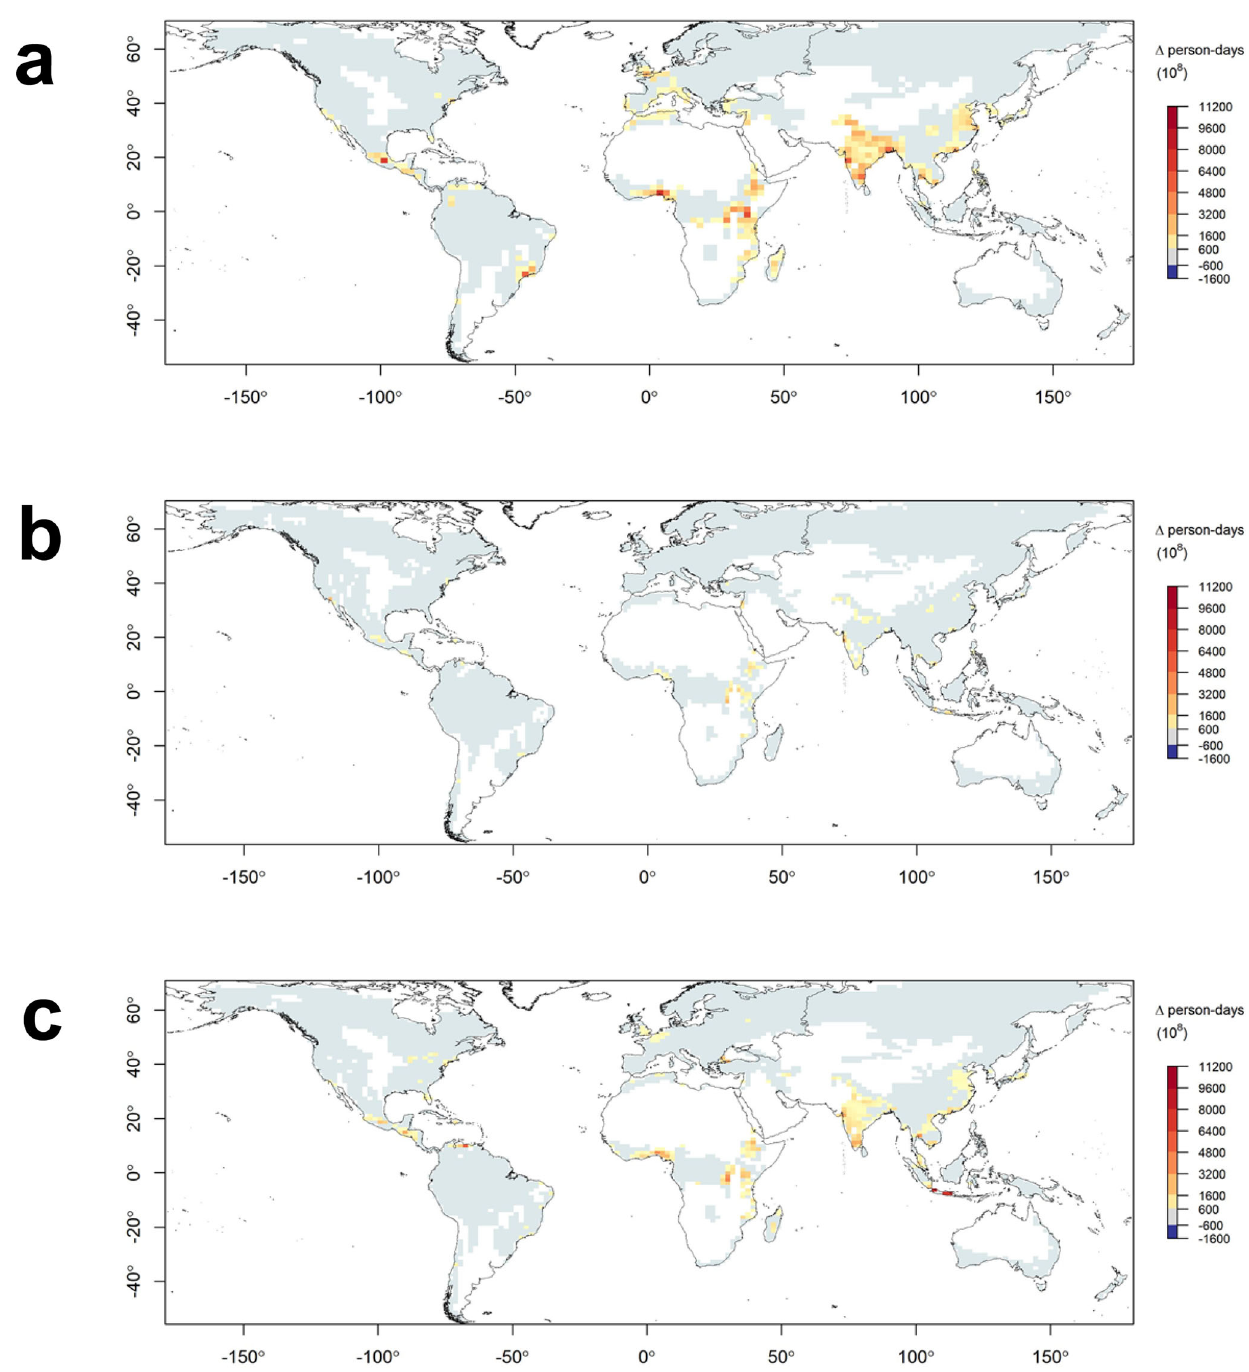
Fig. 5 | Change in population exposure to changes in the mean annual frequency of days exceeding the VPD threshold by 2081 – 2100 under RCP8.5. Results are shown for GFDL-CM3 ( a ), CNRM-CM5 ( b ) and ACCESS1.0 ( c ) models. Units are person-days of exposure. The white areas indicate non-forest